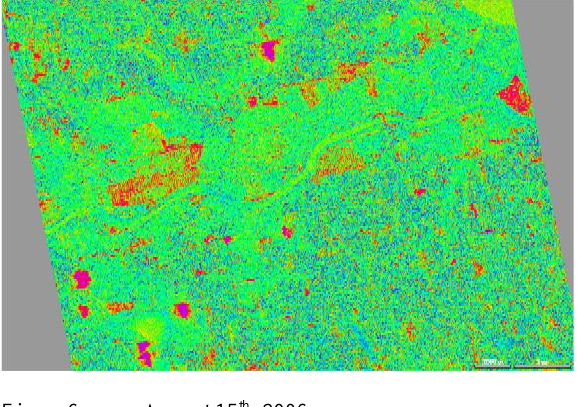
Figure 6. August 15 th , 2006 Results of conventional full-polarization SAR data analysis are indicated the following figures.